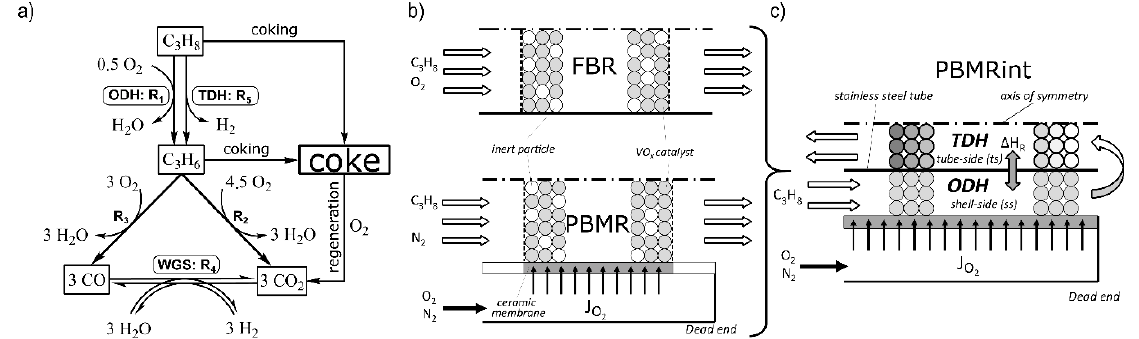
Figure 1. ( a ) Reaction network of ODH including coke formation; ( b ) schemes of reactor concepts FBR and PBMR; ( c ) scheme of the new developed PBMRint.